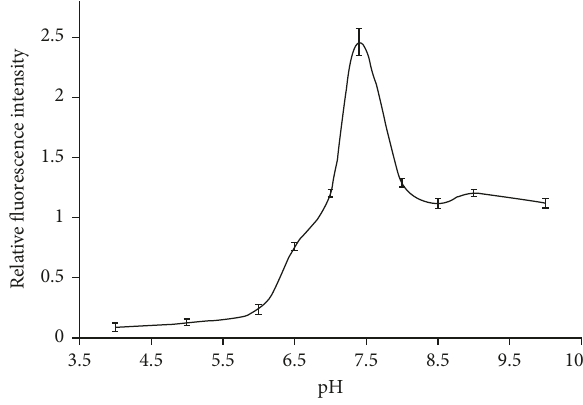
Figure 7: Curve of pH change in MOR competitive fluorescence immunoassays.